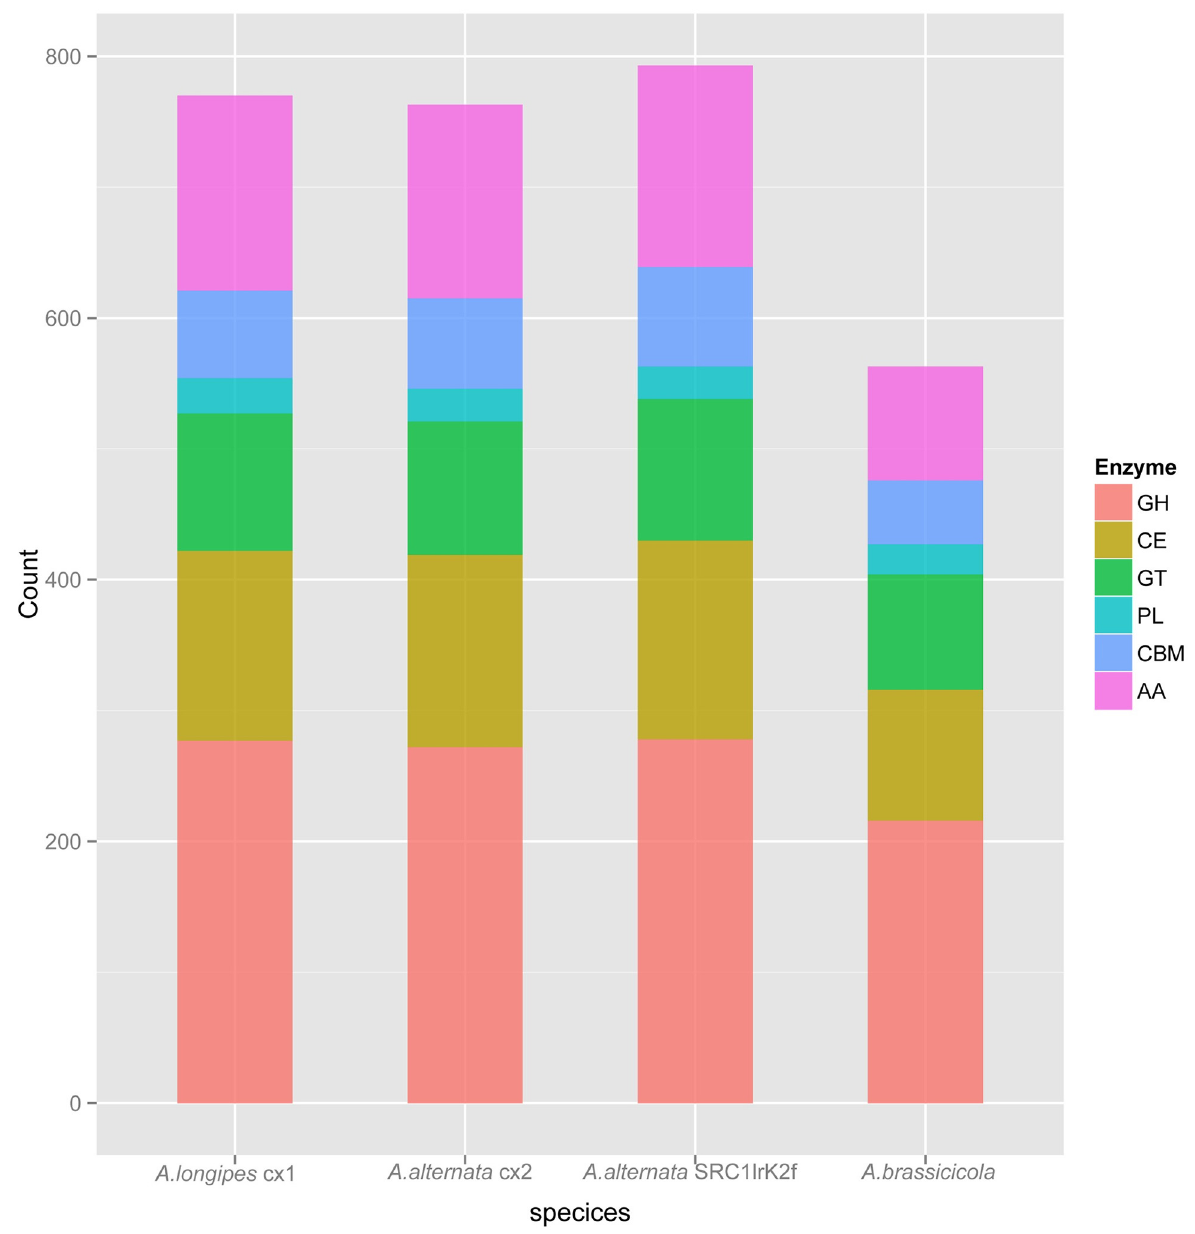
Fig 8. Distribution of carbohydrate-active enzymes gene families in A . longipes cx1, A . alternata cx2, A . abrassicicola and A . alternata